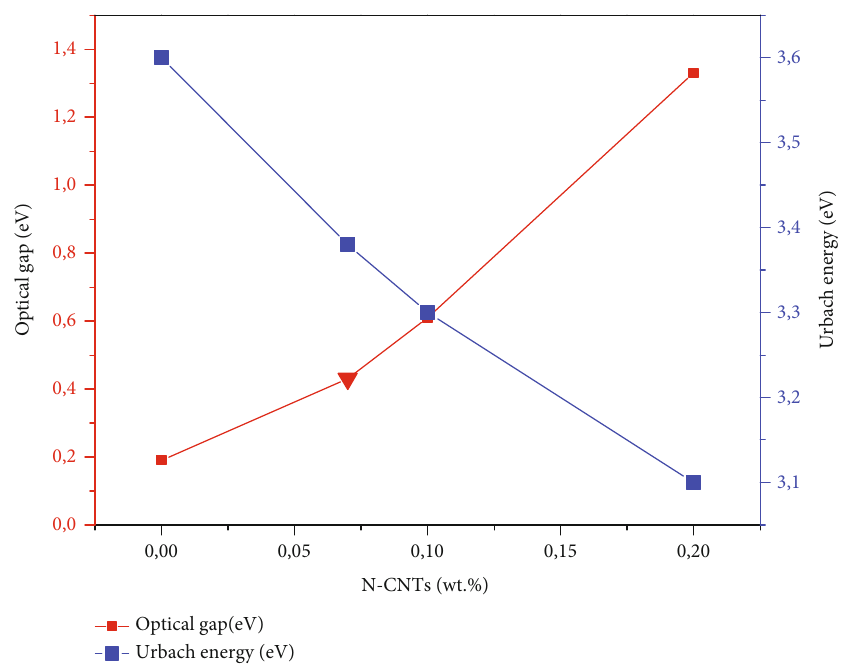
Figure 6: Variation of optical gap and Urbach energy of epoxy/silicone composite fi lms versus wt% N-CNT.